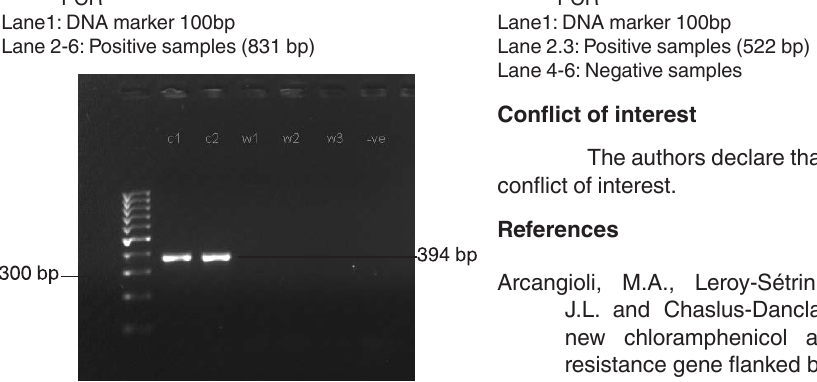
Fig. 3 . Agarose gel electrophoresis of tetA specific PCR Lane1: DNA marker 100bp Lane 2-6: Positive samples (831 bp)